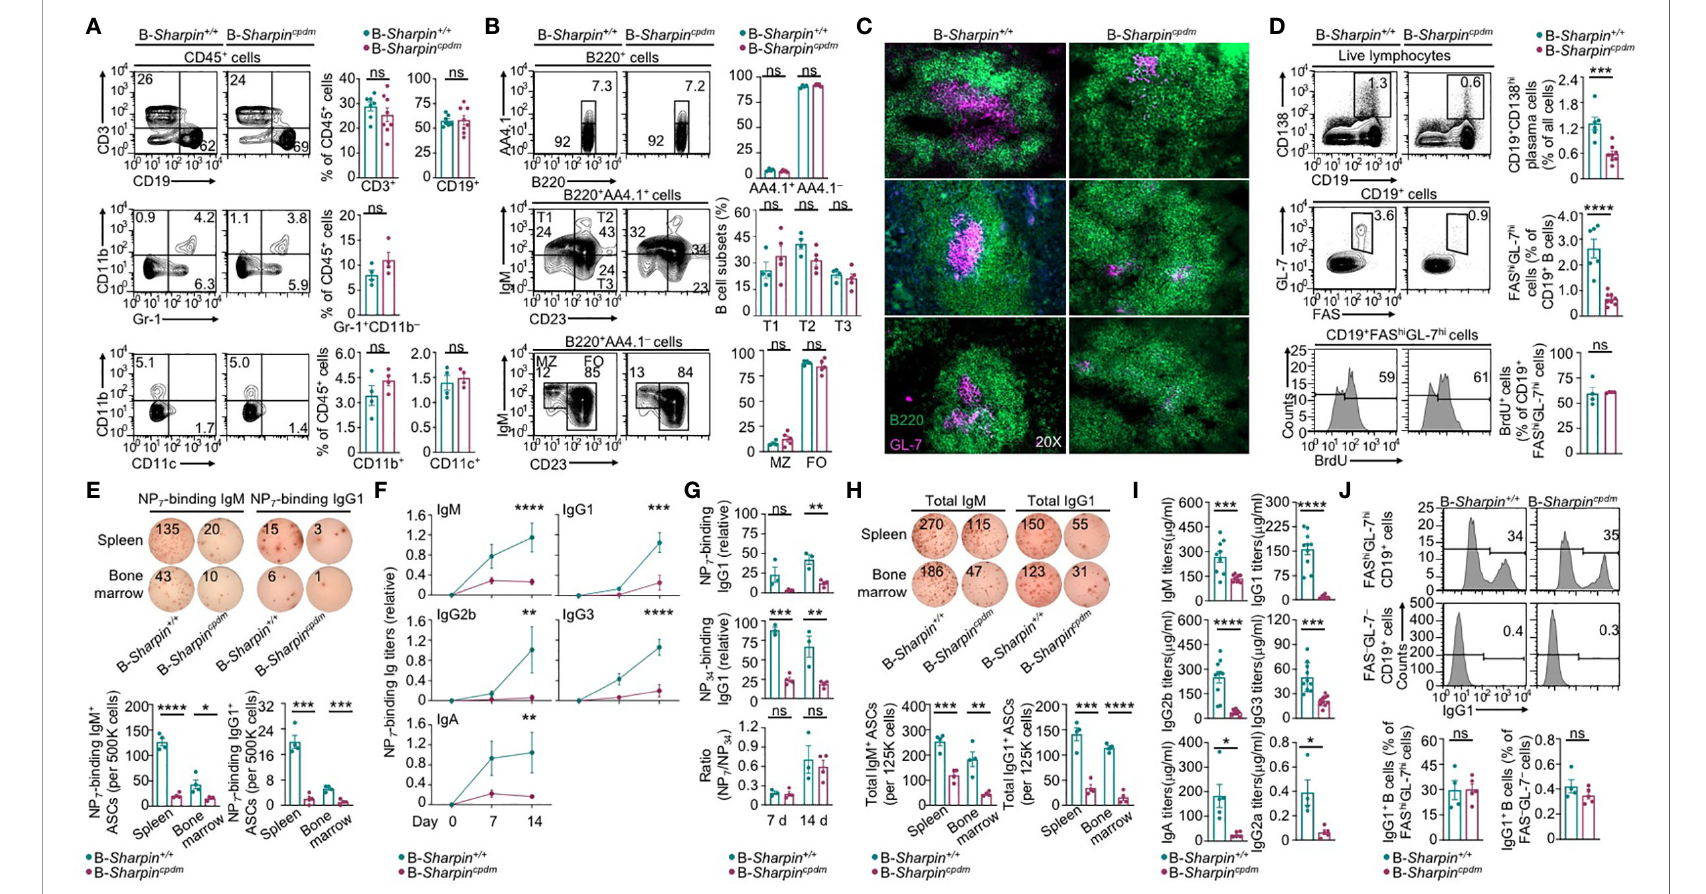
FIGURE 1 | B cell-intrinsic role of SHARPIN in the GC development and Ab responses. (A, B) Flow cytometry analysis of different immune cell populations, as indicated, in the spleen of B- Sharpin +/+ or B- Sharpin cpdm mice immunized with NP-CGG/alum for 14 d. (C) Fluorescence imaging analysis of GCs in the spleen in mice, as in (A, B) . (D) Flow cytometry analysis of plasma cells, GC B cells, and GC B cell proliferation (by BrdU incorporation) in immunized mice. (E – G) ELISPOT analyses of ASCs producing NP-speci fi c IgM or IgG1 in the spleen and the bone marrow in mice 14 d after immunization (E) and ELISA of circulating NP 7 -binding and NP 34 -binding Ig Abs 7 and 14 d after immunization (F, G) . (H, I) ELISPOT analyses of ASCs producing total IgM or IgG (H) and ELISA of circulating total Ig Abs (I) in mice, as in (E, F) . Data are pooled from 2 independent experiments. (J) Flow cytometry analysis of surface IgG1 expression in GC and non-GC B cells. * p <0.05; ** p <0.01; *** p <0.001; **** p <0.0001; ns, not signi fi cant;